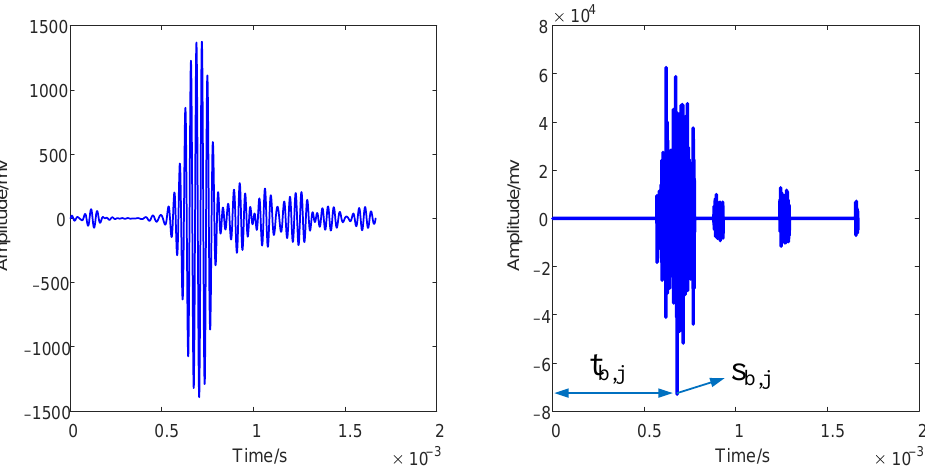
Figure 6. Reference signals and sparse representation signals of 2 – 8 channels. According to the waveforms of the 36-channel sparsely represented signals, the cor- responding t b,j , s b,j , t d,j , s d,j can be obtained. Putting the above four parameters into Formula (9), the damage factor based on the Lamb wave sparsely represented for each channel can be obtained. Figures 8–10 are the energy damage factors, cross-correlation damage factors, and damage factors based on Lamb wave sparse representation for fatigue stretching cycles of 20,000, 80,000, and 90,000 times, respectively. The horizontal coordinate is the channel number, and the vertical coordinate is the damage factor